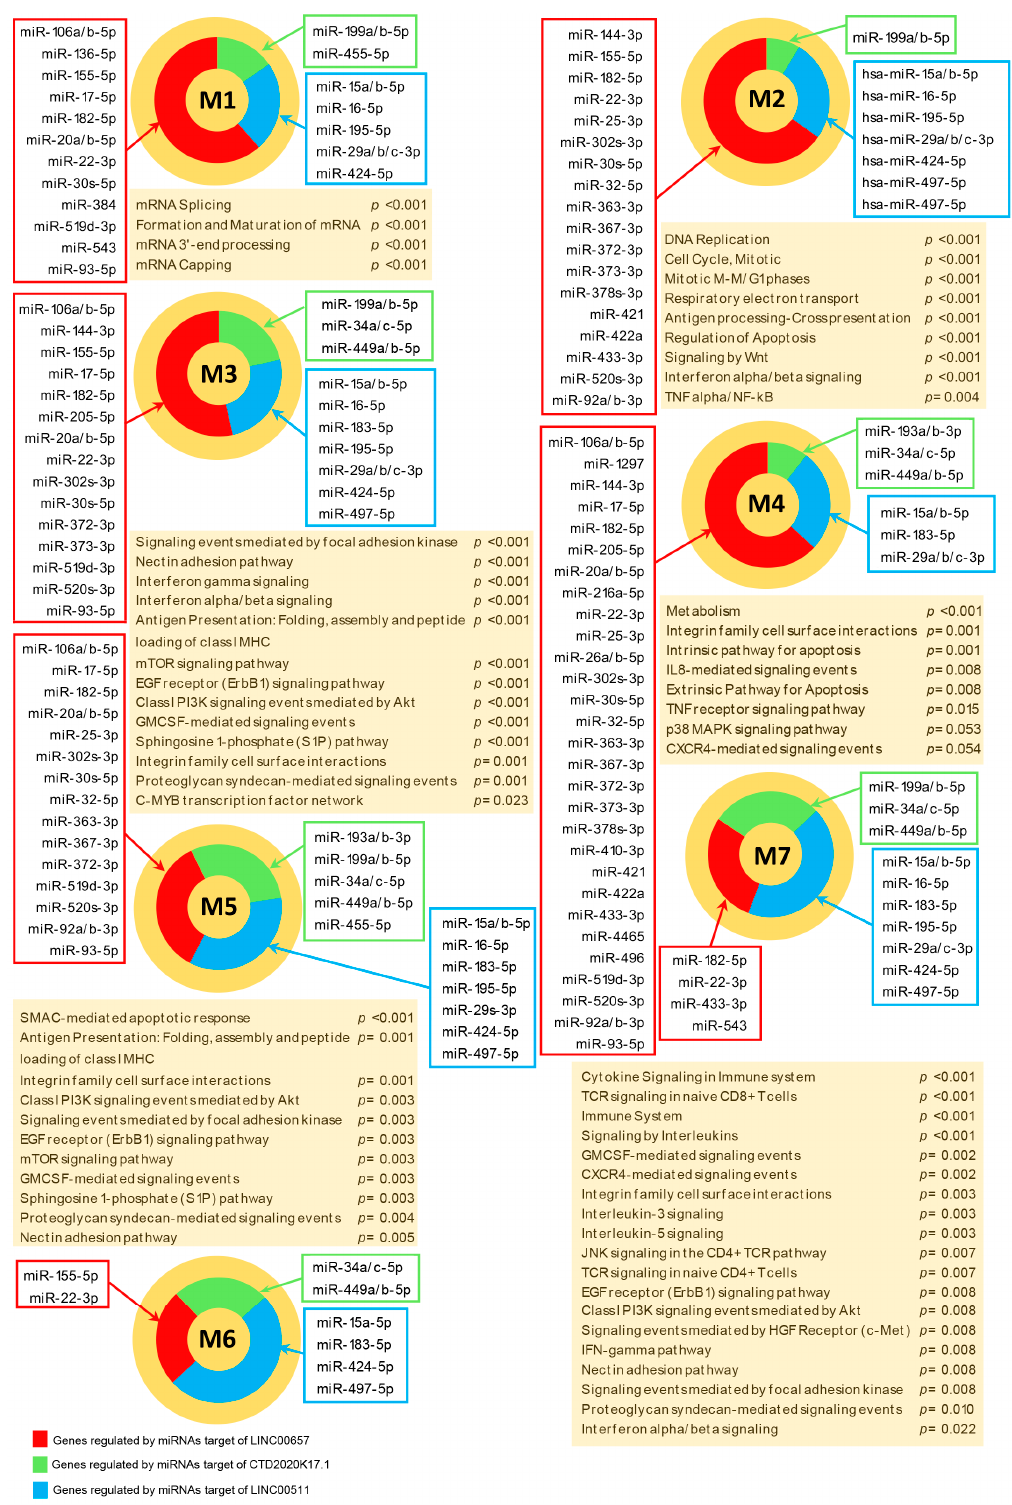
Figure 4. Pathways enrichment of modulated genes included in the modules. Orange circles represent the seven modules and selected enriched pathways in each module are listed in the orange boxes along with their relative statistical significance ( p -value). Colored pie-charts indicate the percentage of genes targeted in each module by CTD-2020K17.1 (green); LINC00657 (red) and LINC00511 (blue). Colored boxes indicate miRNAs that target genes included in the modules and that are targeted by CTD-2020K17.1 (green box), LINC00657 (red box) and LINC00511 (blue box).